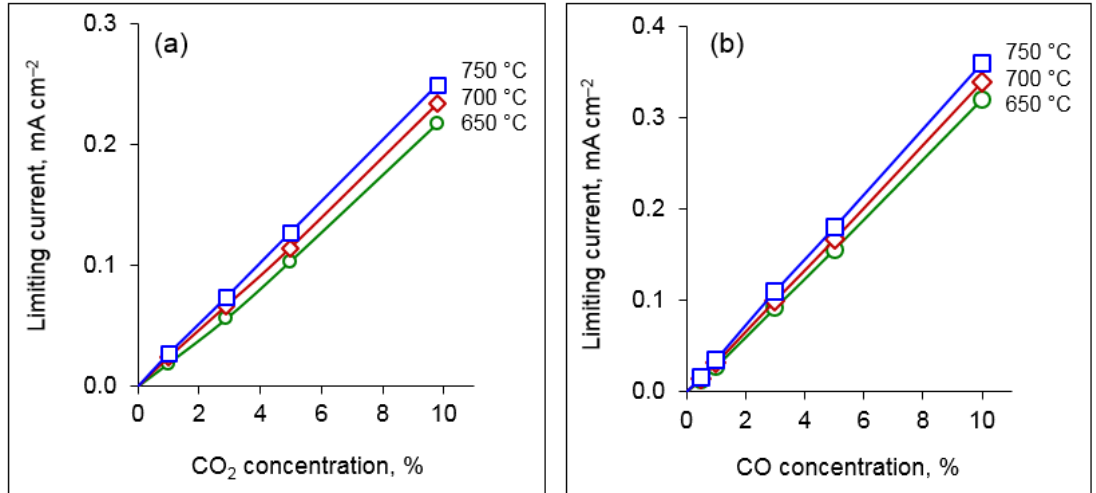
Figure 6. Limiting current vs. ( a ) CO 2 concentration in N 2 + CO 2 gaseous mixture, ( b ) CO concentra- tion in N 2 + CO gaseous mixture. Error bars are smaller than the symbol size.